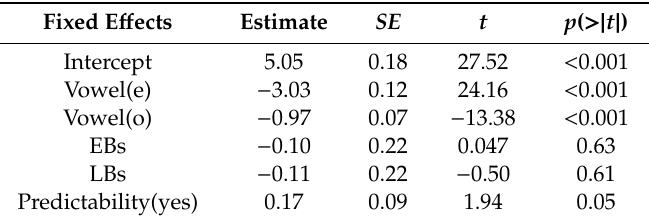
Table 8. Results of a linear mixed e ff ects model for the F2–F1 (Bark) with Participant as a random e ff ect and Vowel, Language Group, and Predictability of the noun gender as fixed e ff ects. Reference values: Vowel = [a]; Language Group = Monolinguals; Predictability =